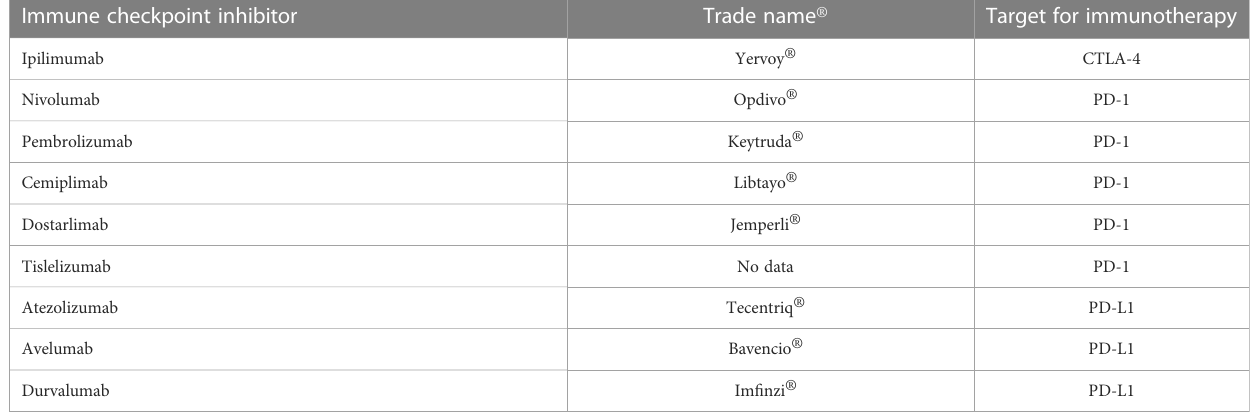
TABLE 1 Immune checkpoint inhibitors approved by the Food and Drug Administration and European Medicines Agency. Immune checkpoint